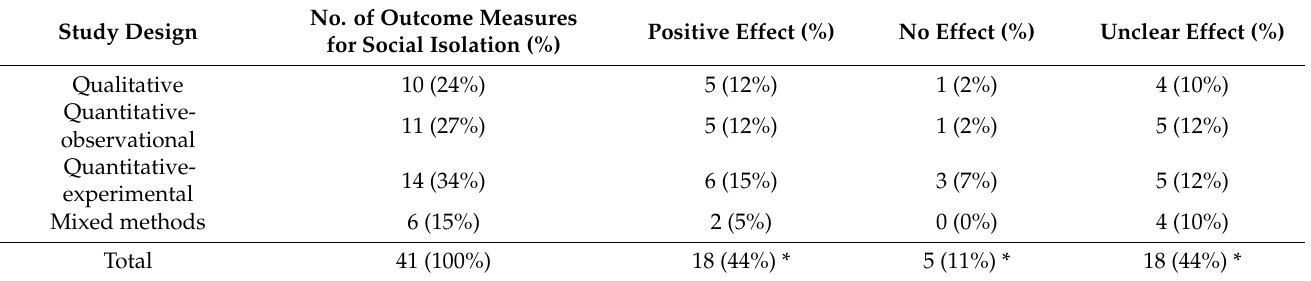
Table 6. Effects of CT Use on Social Isolation Among Older Adults as Reported by Included Reviews Grouped According to Study